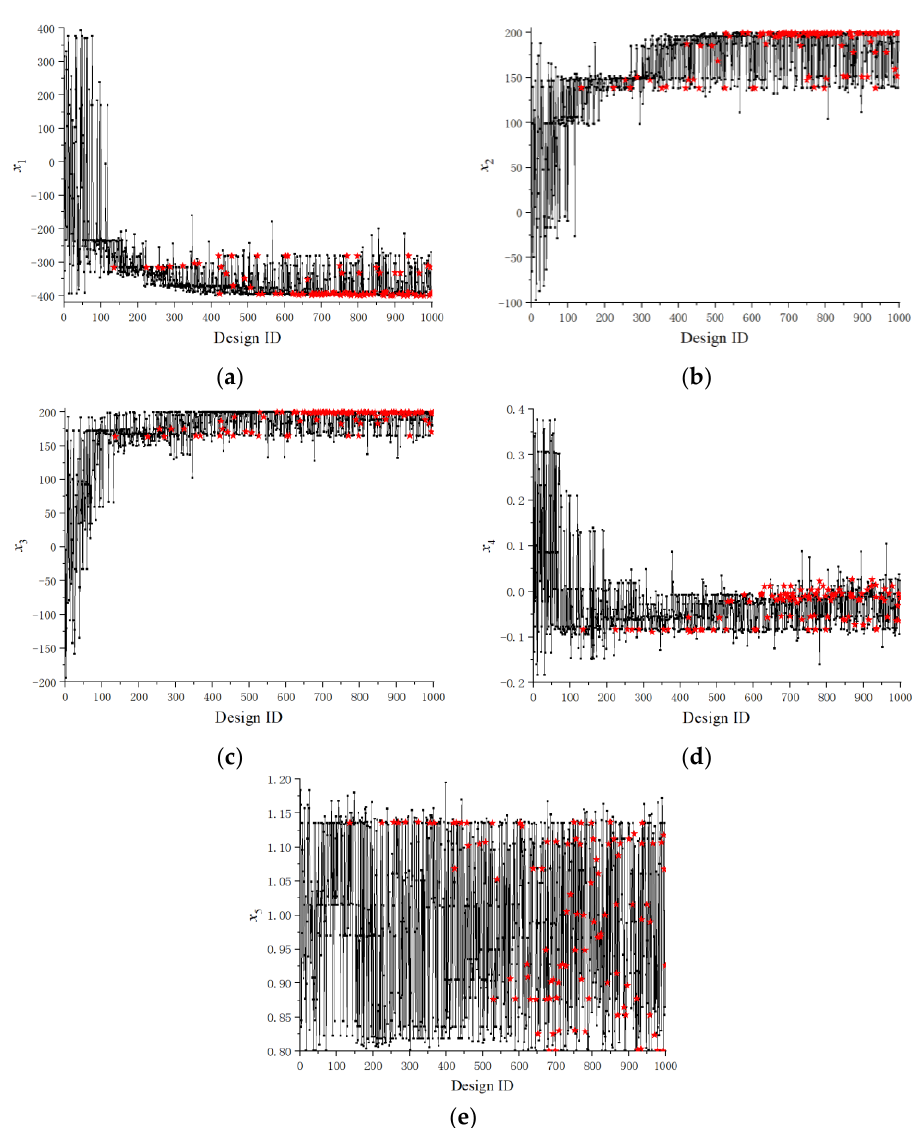
Figure 7. Histories of optimization design variables: ( a ) x 1 , ( b ) x 2 , ( c ) x 3 , ( d ) x 4 , ( e ) x 5